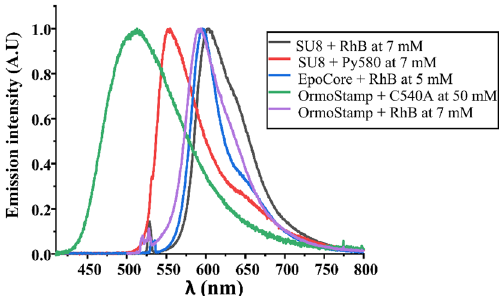
Figure 4. Emission spectra of dye doped thin films.